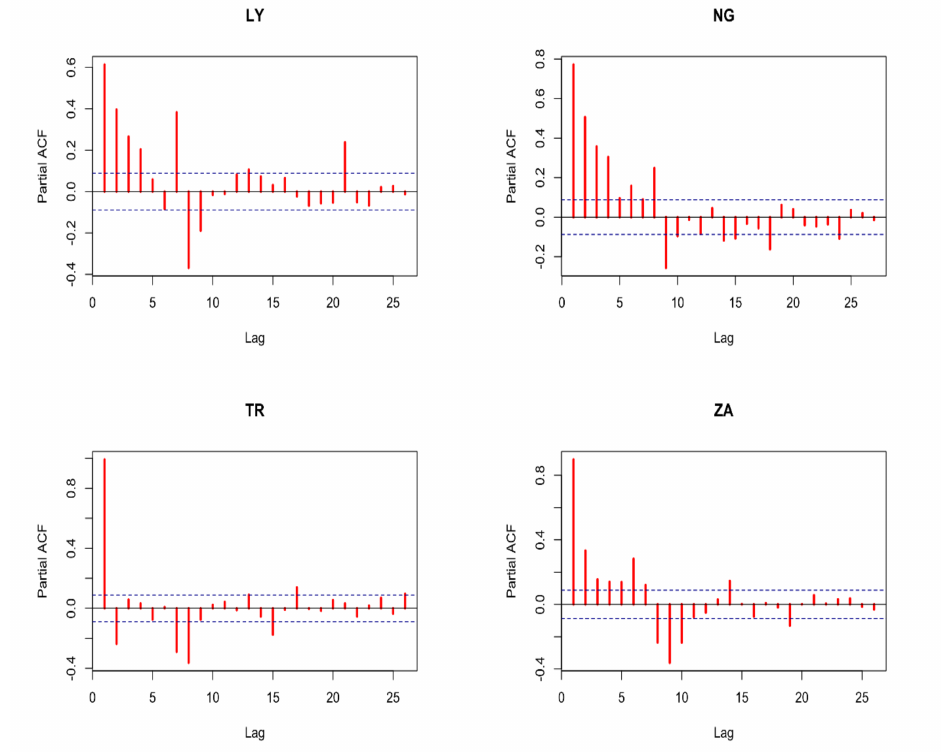
Figure 9. PACF of the first difference of CCC for the four